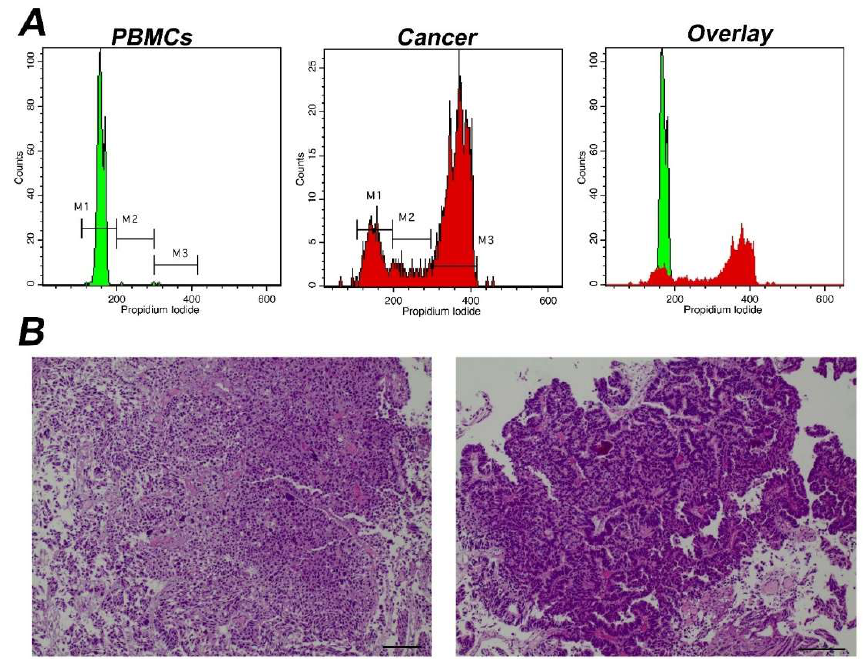
Figure 3. Analysis of a representative tumor with α high Tumor-index ( A ) Analysis using iFC of cell cycle distribution. Peripheral blood mononuclear cells/PBMCs ( left panel ) and tumor cells obtained during surgery ( middle panel ) were stained with propidium iodide, to bind nucleic acids. Markers M1, M2, M3 are used to gate cells in G1, S and G2/M phases, respectively, as explained in Figure 1. The cell fraction in each phase (presented in upper right corner of each histogram) is used to quantify Tumor-index, a marker used to determine the presence of malignant cells in a given sample. ( B ) pathology assessment. A papillary urothelial carcinoma of the bladder, high-grade, following hematoxylin-eosin staining. Original magnification × 40 ( left panel ) and × 100 ( right panel ). Scale bars represent 50 um ( left photo ) and 100 um ( right photo ),